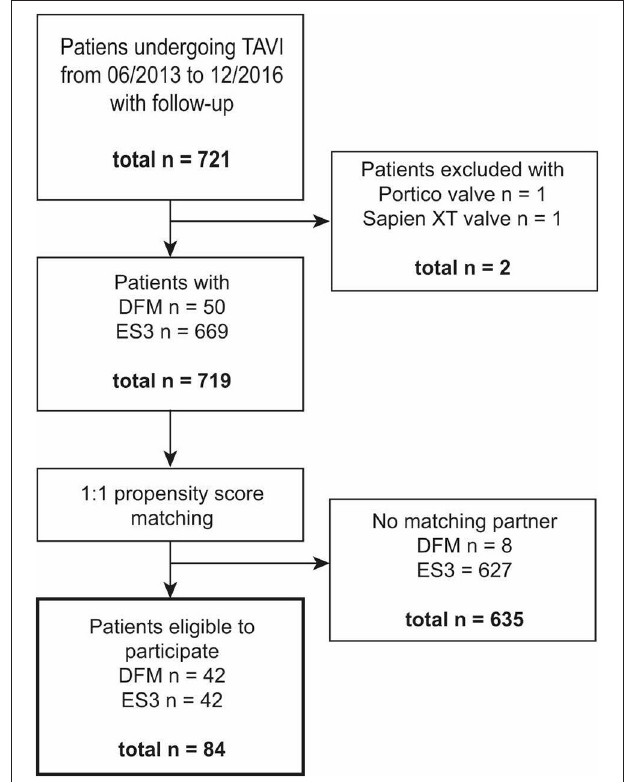
FIGURE 1 | Patient flow through the study. Figure shows patients included and excluded in the study with a number of n individuals at each step. TAVI, transcatheter aortic valve replacement; DFM, direct flow medical prosthesis; ES 3, Edwards Sapien 3